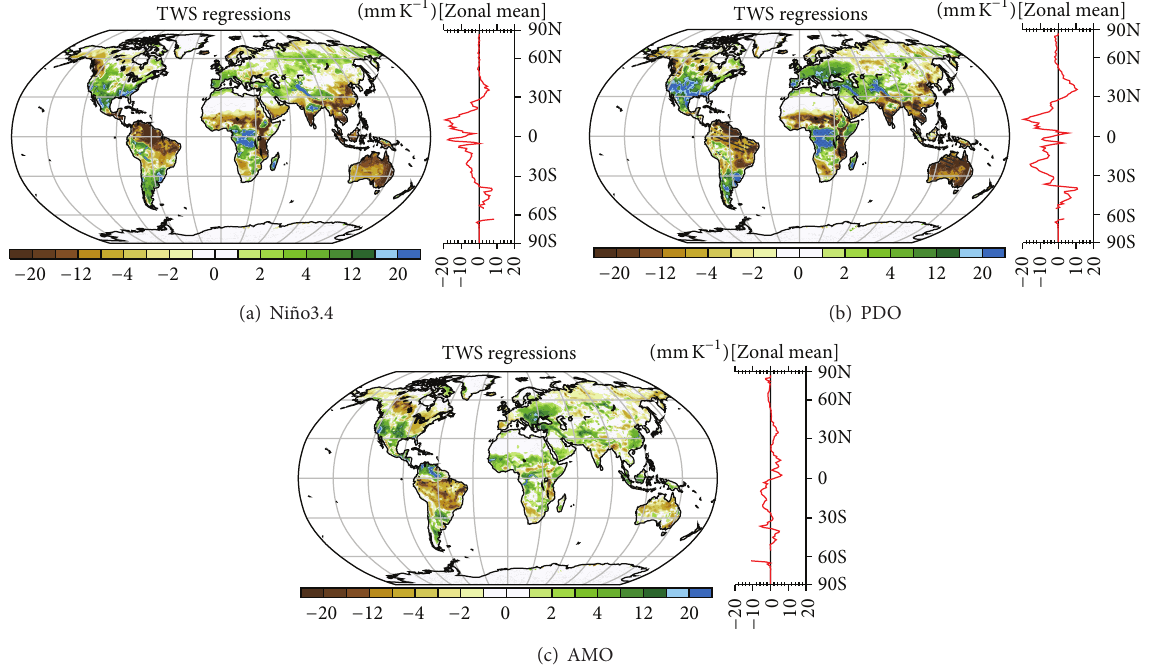
Figure 5: Regressed contributions to TWS of (a) ENSO as estimated from Ni˜no3.4 SST and (b) the PDO and (c) AMO indices from the LE control